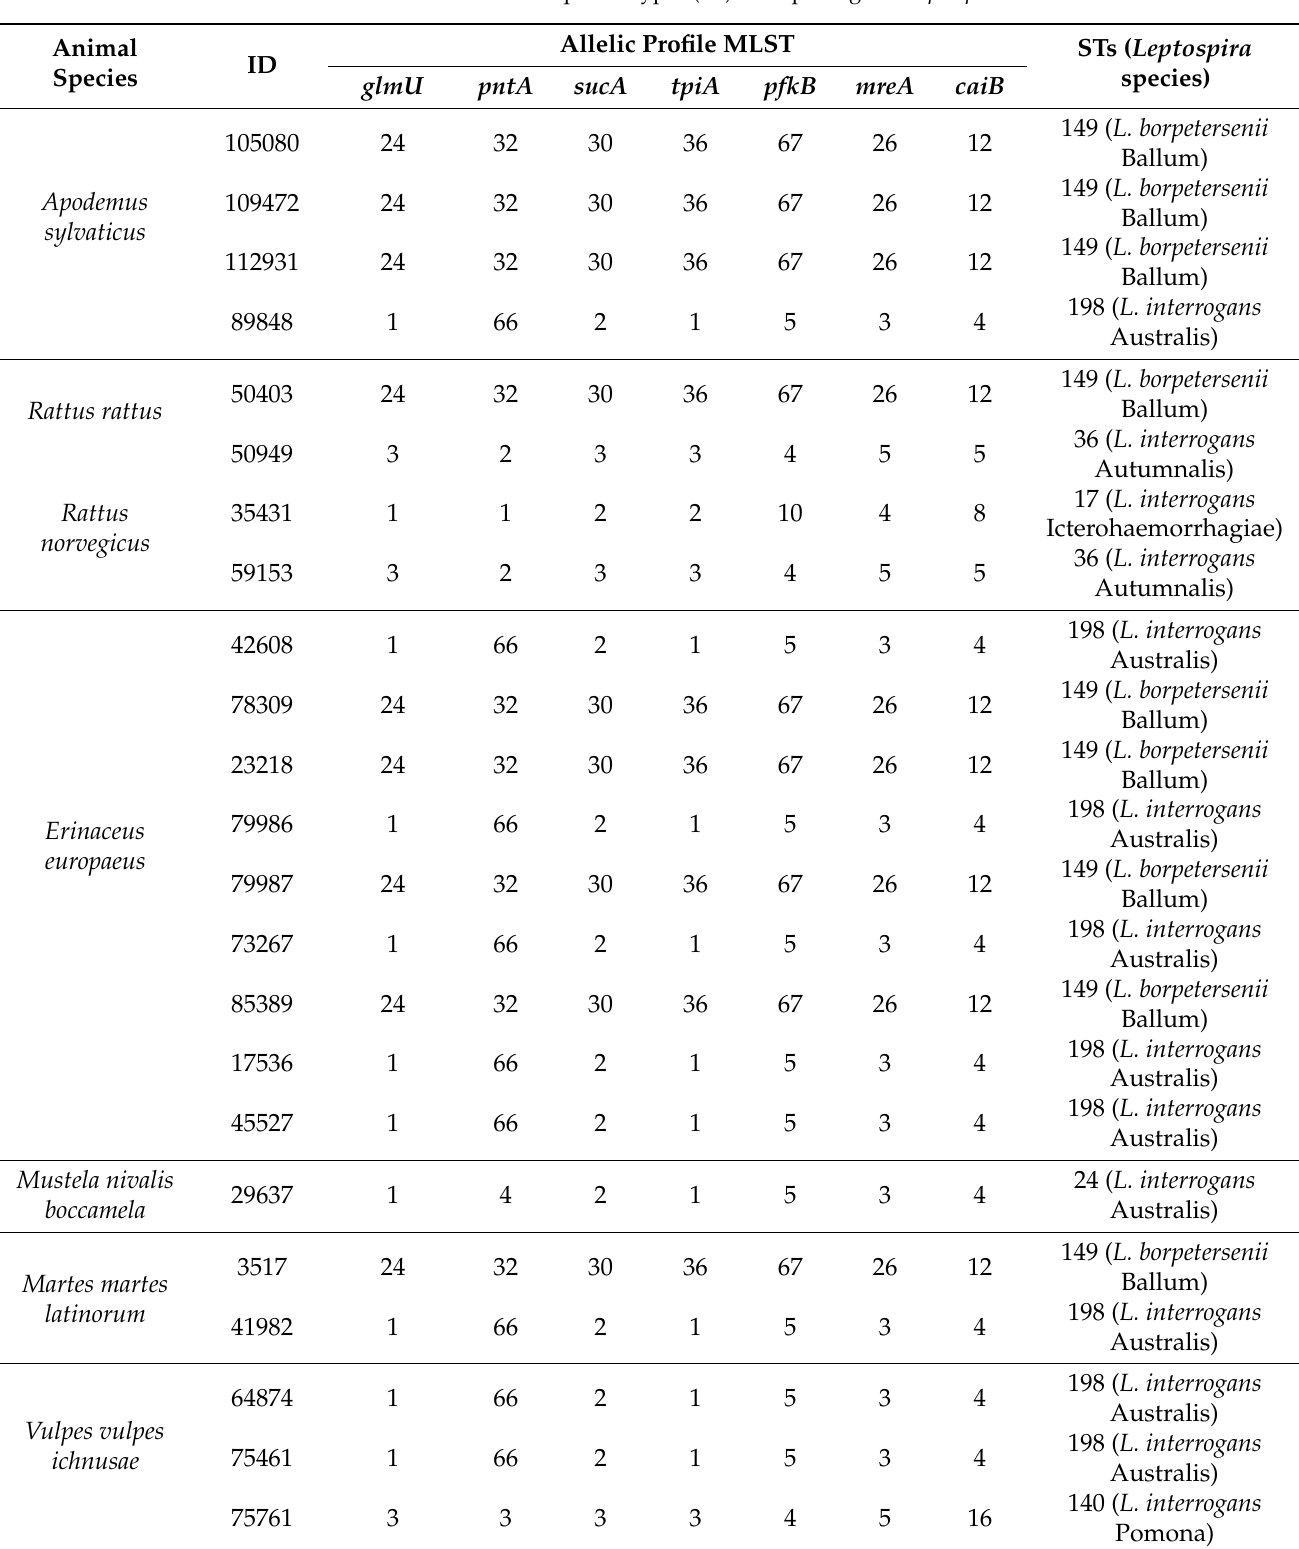
Table 4. Numbers of alleles and sequence types (ST) of 23 pathogenic Leptospira strains.